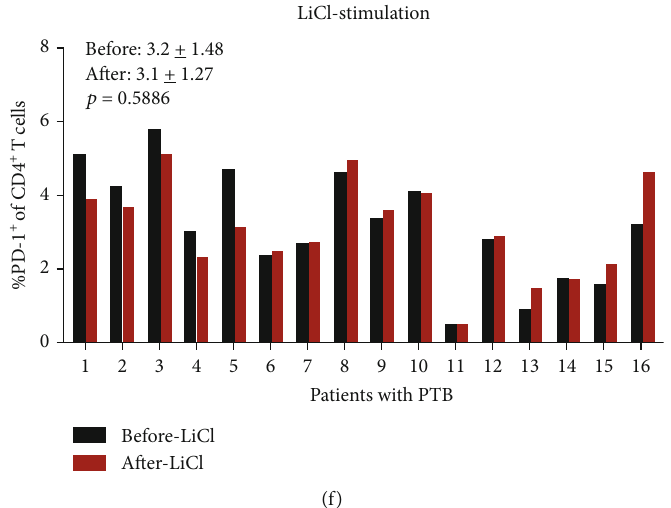
Figure 5: PBMCs cultured with LiCl to stimulate the production of β -catenin. (a) Signi fi cant increase in the β -catenin expression on CD4 + T cells after LiCl stimulation, n = 16 . (b) Signi fi cant increase in the CD4 + frequency after LiCl stimulation, n = 16 . (c) Signi fi cant increase in the IFN- γ expression on CD4 + T cells after LiCl stimulation, n = 16 . (d) Signi fi cant increase in the TNF- α expression on CD4 + T cells after LiCl stimulation, n = 16 . (e) The ELISA result showed similar IFN- γ expression before after LiCl stimulation, n = 10 . (f) No changes of PD-1 expression on CD4 + T cells after LiCl stimulation, n = 16 . All results were analyzed by the paired Student t